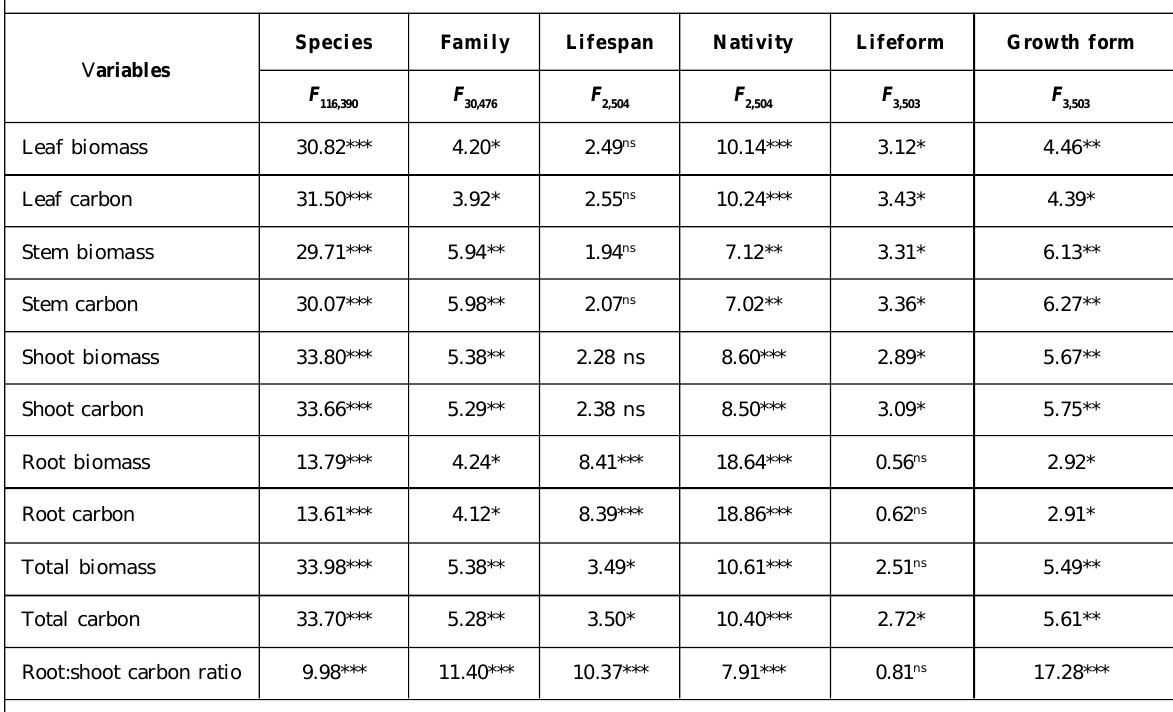
Table 1: Summary of ANOVA ( F- value and degree of freedom) of dry weight (biomass) and carbon contents in different plant components of herbaceous species due to variations in species, family, lifespan, nativity, life and growth